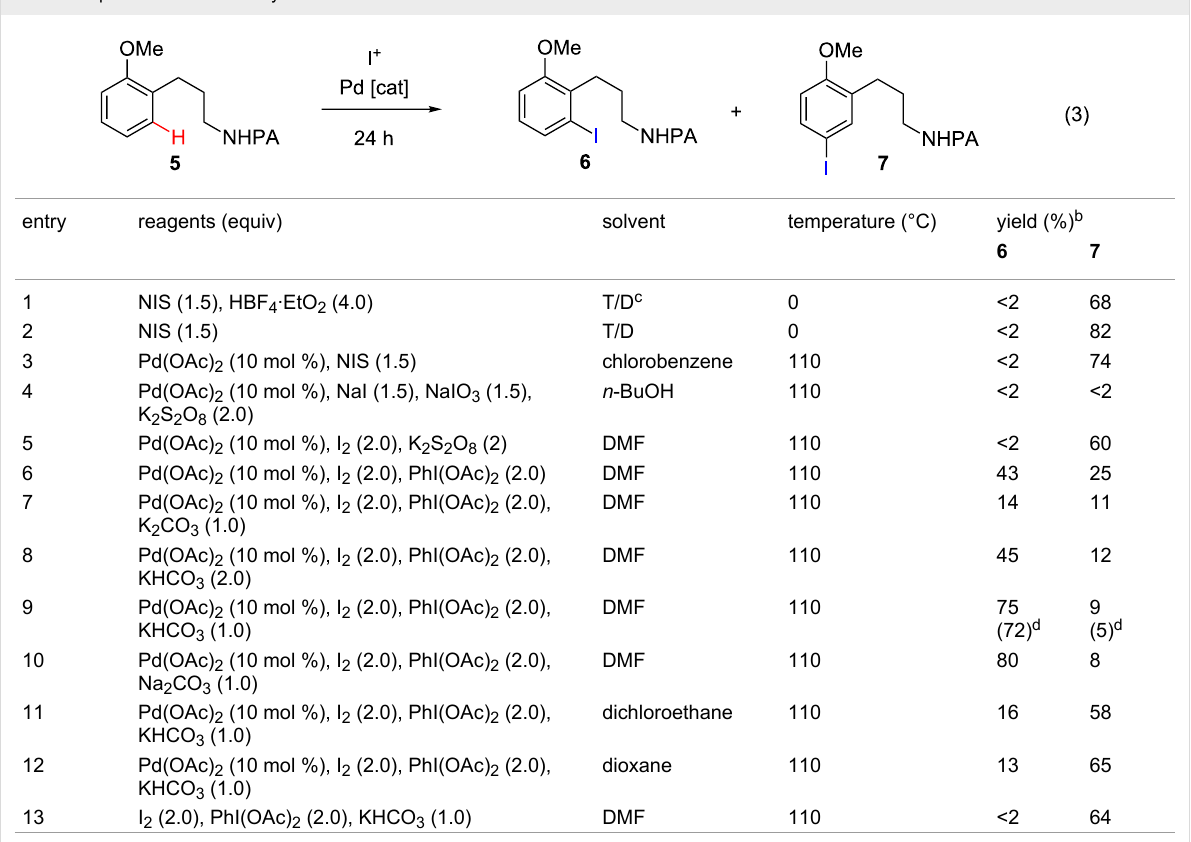
Table 1: Optimization of Pd-catalyzed ortho C − H iodination of 5 .